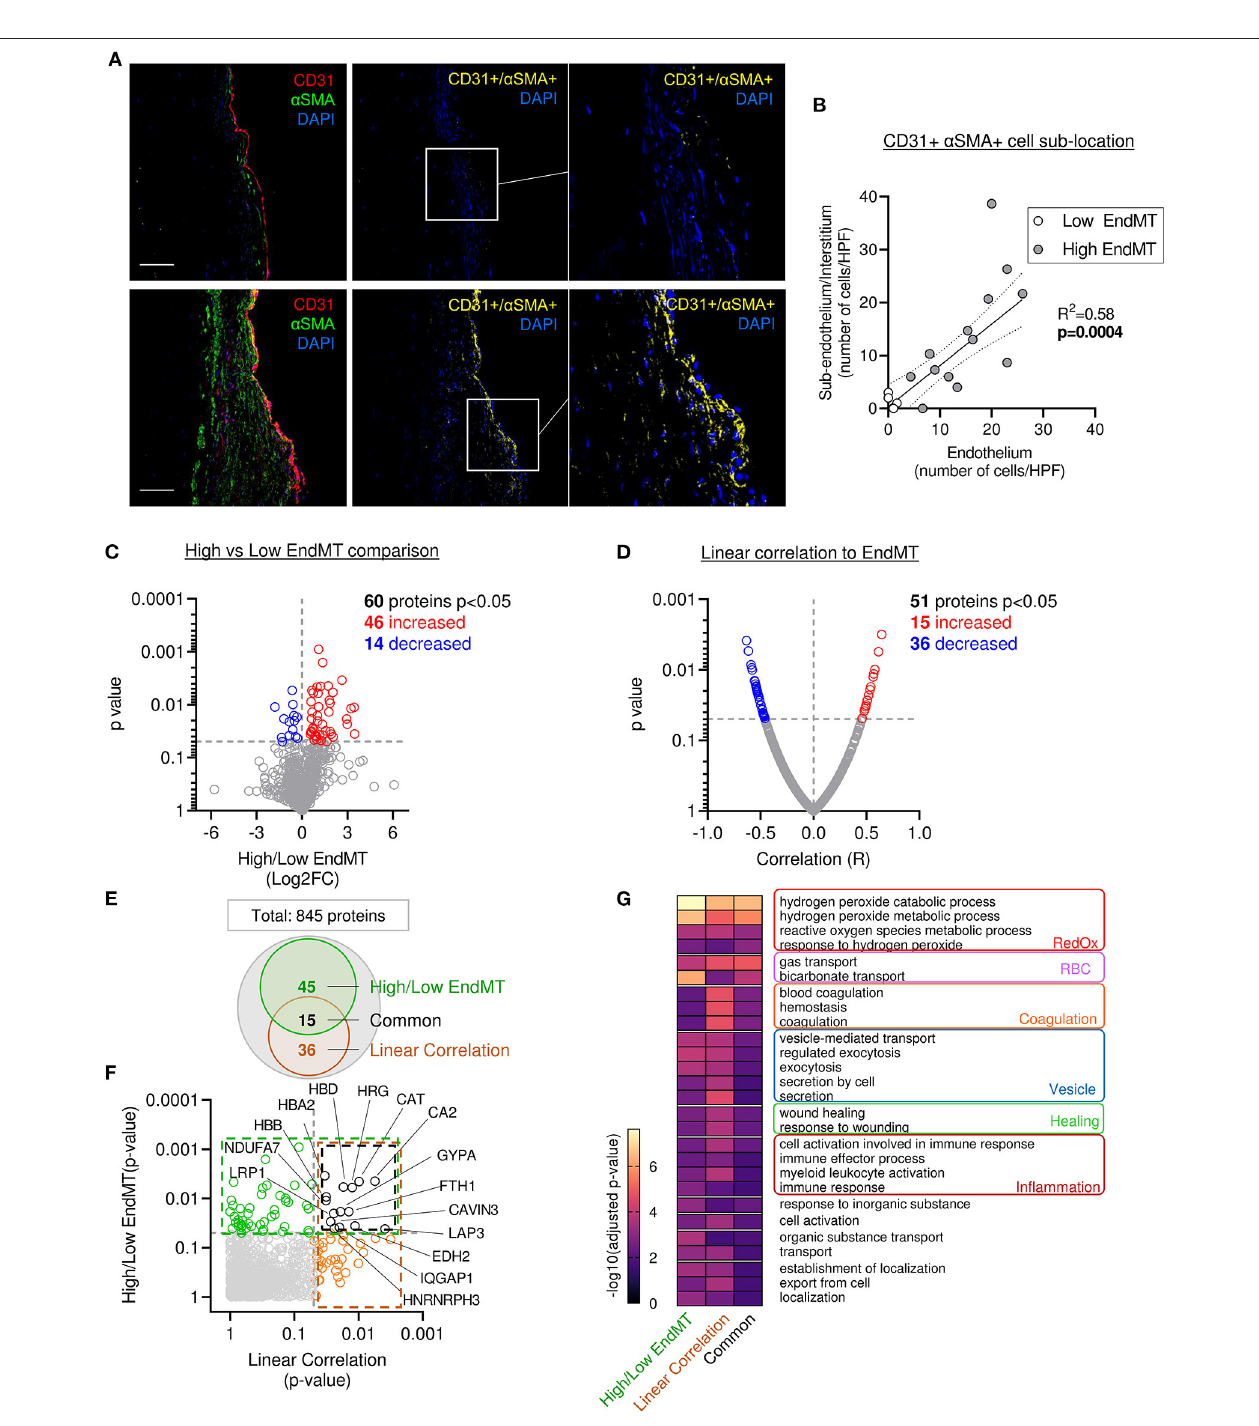
FIGURE 5 | Mitral leaflets displaying EndMT are associated with proteomic change associated to, oxidative stress-, inflammatory- and vesicle-related processes. (A) Representative mitral valve section from patient with different range of cellular composition, (patients #10 upper panel and #12 bottom panel) stained for DAPI (blue), CD31 (red), α SMA (green) merge on the left panel (scale bar represent 100 µ m). CD31 and α SMA double positive areas are represented in yellow (two right panels). (B) Sub localization of EndMT cells (CD 31 + α SMA + DAPI + ) between endothelium layer (x axis) and sub endothelium and interstitium area (y axis). (C) Comparison of proteomic composition from the four samples having low level of EndMT (white dots in B ) vs. the 13 other samples with higher level of EndMT (gray dots in B ). Volcano plot displaying the Log2 fold change (x axis) against the statistical p -value (log scale) for all 845 proteins detected. Proteins with significantly increased expression (Log2FC > 0, p < 0.05) in sample with high level of EndMT are shown in red, while the proteins with significantly decreased expression (Log2FC > 0, p < 0.05) are